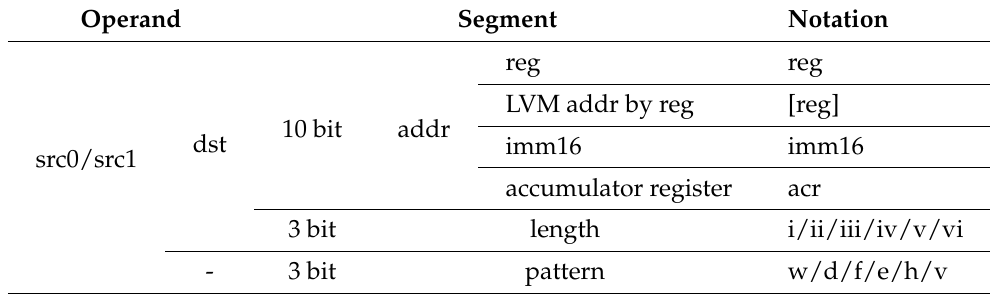
Table 6. Address